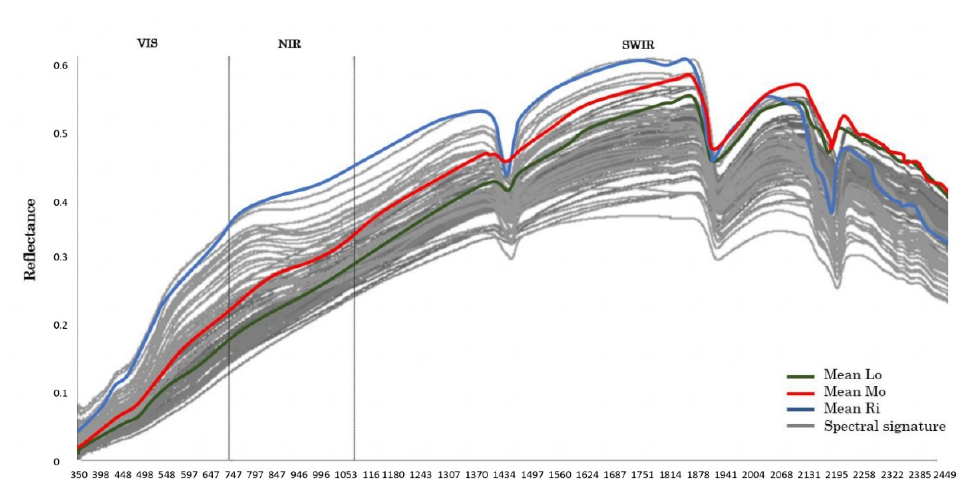
Figure 3. Spectral signatures of the 96 analyzed soil samples (spectral signature), and average spectral signatures of Lobeira (Mean Lo), Monteveiga (Mean Mo) and Ribadulla (Mean Ri). Table 2. Statistics of random forest regressions using no transformed spectral data (RF) and calculating previously principal components